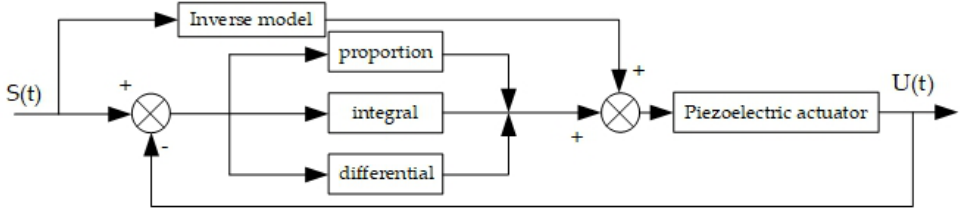
Figure 8. Control system structure with inverse model feedforward and feedback.